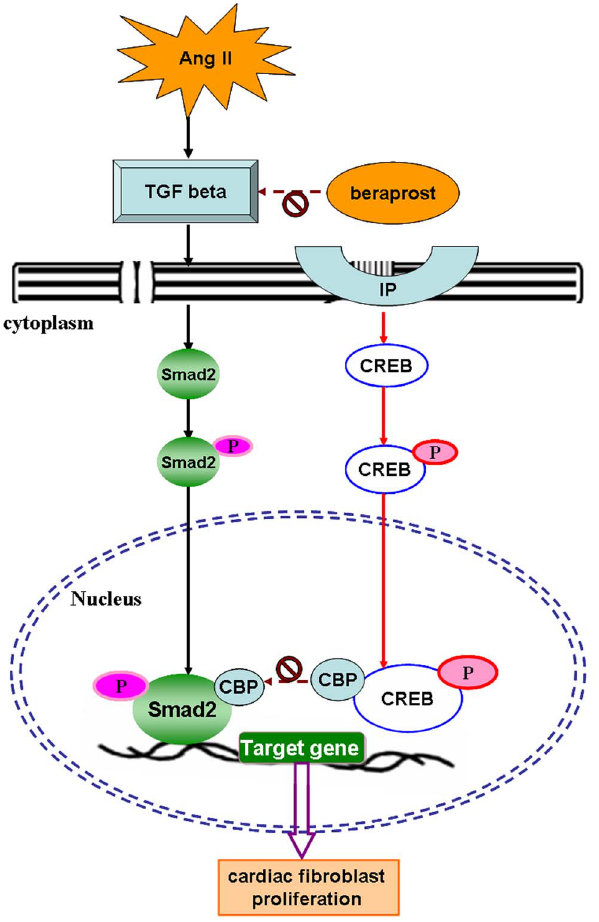
Figure 9. Illustration for mechanism of beraprost-mediated inhibition on cardiac fibroblast proliferation. In response to an Ang II stimulus, TGF b -Smad signal pathway is activated in cardiac fibroblasts. More phosphorylation of Smad2 translocates into nucleus to form a Smad2-CBP complex, which might facilitate fibrotic gene transcription and accelerate cardiac fibroblast proliferation. Beraprost binds to cell surface prostacyclin receptor (IP), phosphorylates of CREB at Ser133 and translocates into nucleus of cardiac fibroblasts, which sequestrates CBP and then prevents Smad-related transcription from performing an anti-fibrotic response. Beraprost may also inhibit TGF b - Smad signal pathway directly to attenuate cardiac fibroblast prolifer- ation but the detailed mechanism needs further study.